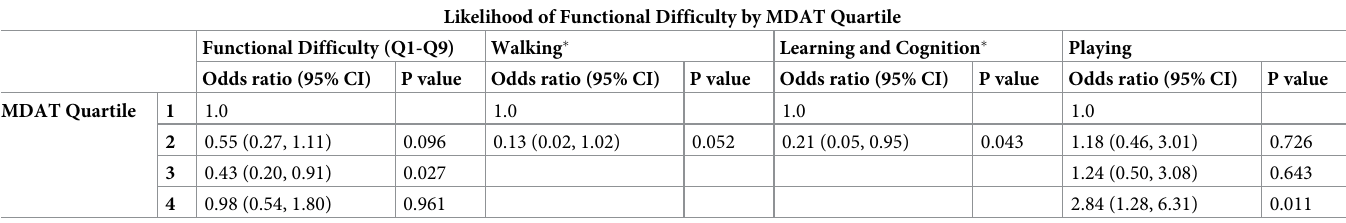
Table 4. Table reporting odds of functional difficulty across quartiles of increasing MDAT score.